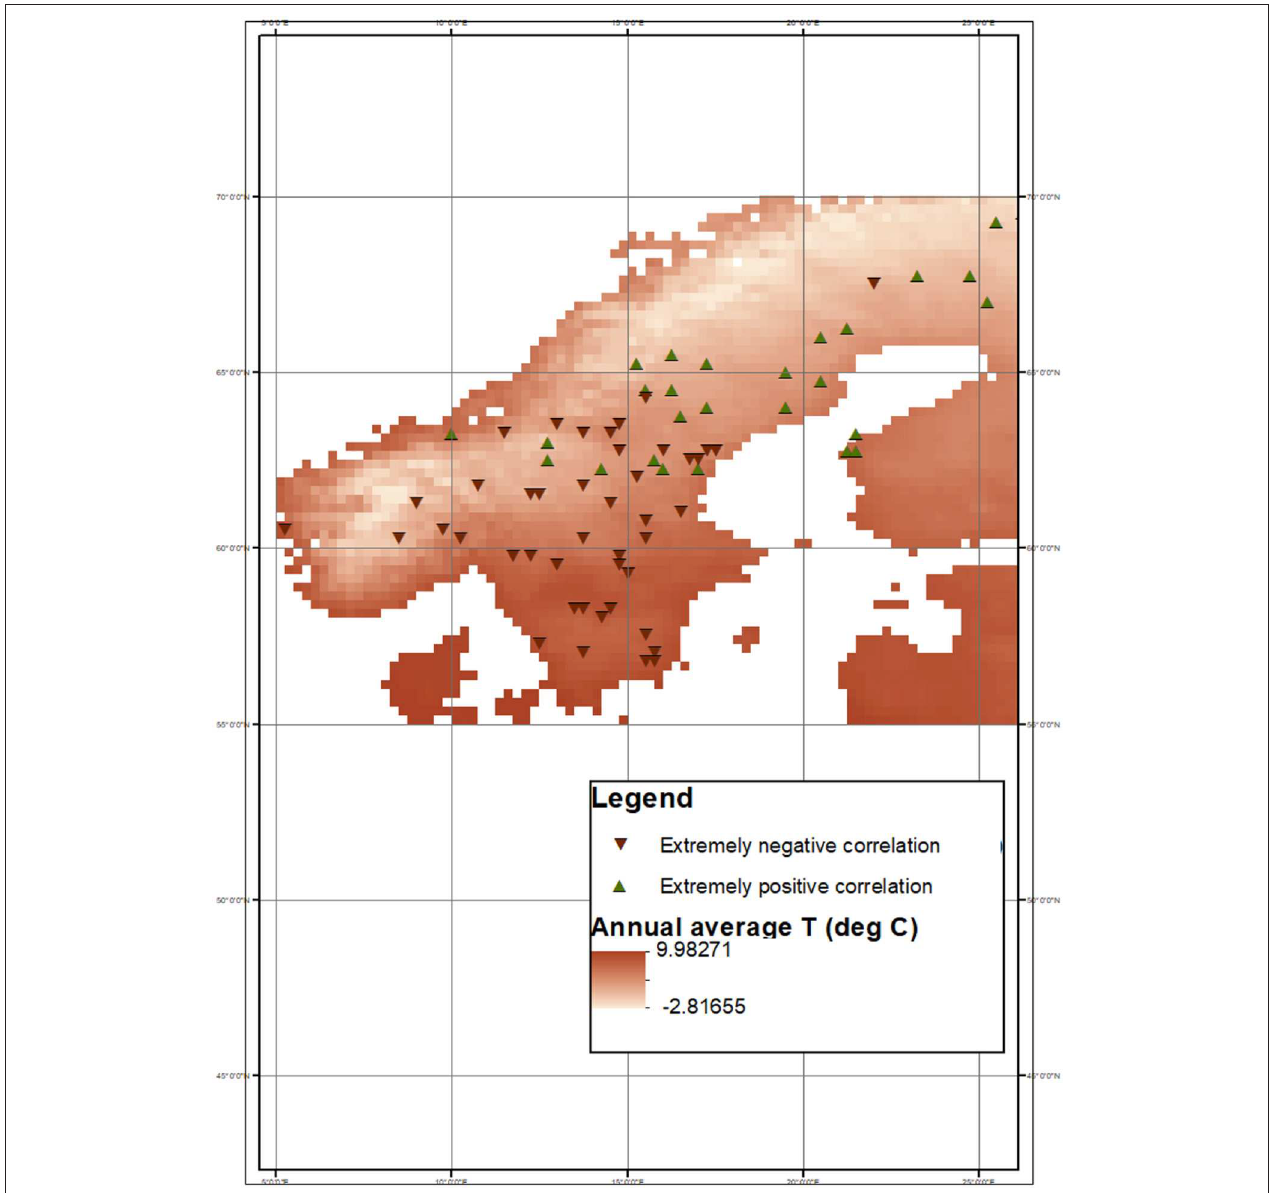
FIGURE 5 | Pixels where extremely positive (90th percentile) and negative (10th percentile) correlation between NDVI GS and DWP GS occur. The annual average T A map was obtained from E-OBS gridded dataset.